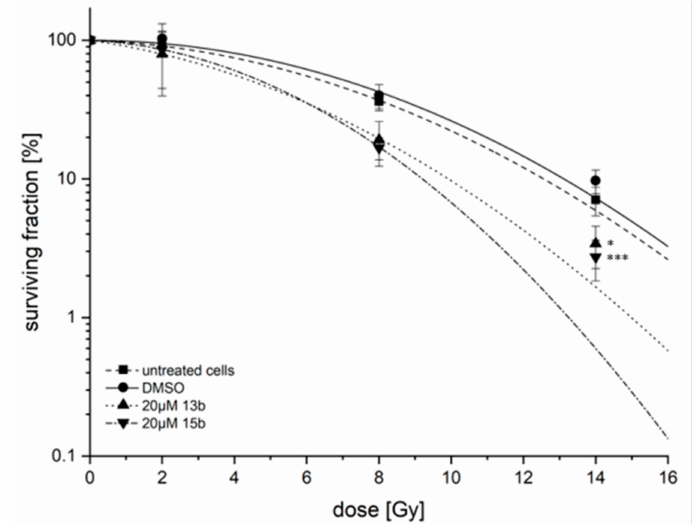
Figure 10. Radiosensitivity of MDA-MB-231 cells under hypoxic conditions. Cells were treated with 20 µ M 13b or 15b for 24 h and irradiated with 0 Gy, 2 Gy, 8 Gy and 14 Gy. A clonogenic survival assay was performed 1 h after irradiation and cultured for 12 d. All colonies that consisted of more than 50 cells were counted. The diagram shows the overall survival [%] and plating efficiency of each treatment; the value at 0 Gy was set as 100%. Data represent mean values ( ± SD) of four independent experiments. EF 14Gy was 3.16 ± 1.36 for 13b (* p = 0.02) and 3.70 ± 0.65 for 15b (*** p <